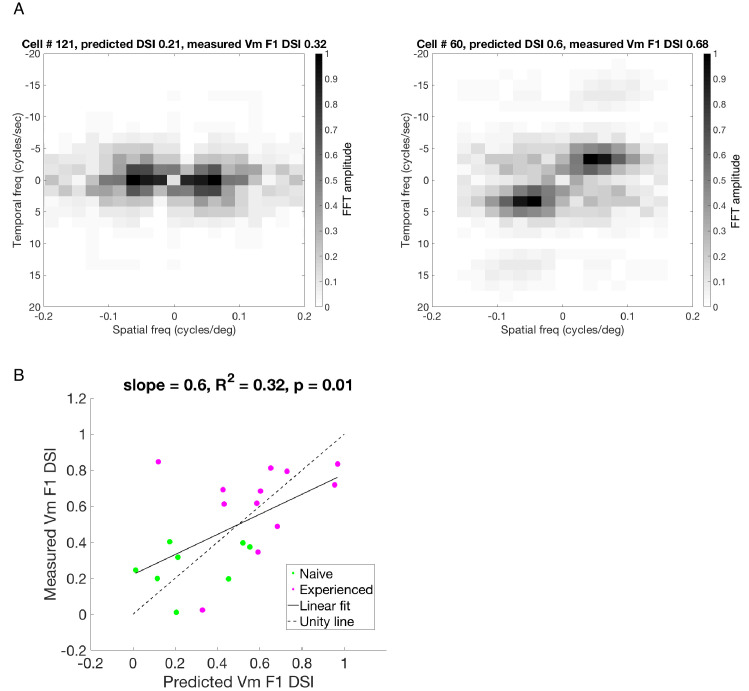
Predicting Vm DSI of the F1 component from the simple cell STRFs.(A) STRFs were Fourier transformed along both space and time axes to convert both dimensions to the frequency domain. The amplitudes were scaled between 0–1 and plotted as a color map image, in which the intensity of every pixel represented the Fourier amplitude of response at a particular spatial and temporal frequency combination. The darkest pixel corresponds to the neurons’ preferred spatial and temporal frequencies. Left: frequency-domain STRF of cell # 121 recorded in a visually naive ferret; Right: frequency-domain STRF of cell # 60 recorded in a visually experienced ferret. In these images, there are four quadrants organized around the origin, which represents 0 spatial and temporal frequency. The two diagonally opposite quadrants contain the same data, and each of the two such diagonal pairs correspond to the two opposite directions of motion each. For example, if the quadrant with positive spatial and temporal frequencies represents forward motion, then the quadrant with positive spatial and negative temporal frequencies represents the backward motion. In a cell with low direction selectivity (left), the intensity of pixels in these two quadrants are similar, whereas in a highly direction selective cell (right), the pixel intensities are strikingly higher in one of the two quadrants. The imbalance of intensities along the two diagonals can be used to predict direction selectivity of the linear component for a simple cell. The summed amplitudes from each of the two quadrants represent predicted amplitudes of Vm responses to the two opposite motions, and we used those predicted responses to calculate a predicted Vm DSI for the linear component of the cell’s response. (B) The predicted Vm DSI of the linear component (F1) and the actual Vm F1 DSI measured in each cell were correlated to each other, and this was true for both the naive and the experienced groups. The overall R2 value of 0.32 implies that the linear spatiotemporal summation properties of the simple cells can account for 32% of the variance in Vm F1 DSI.